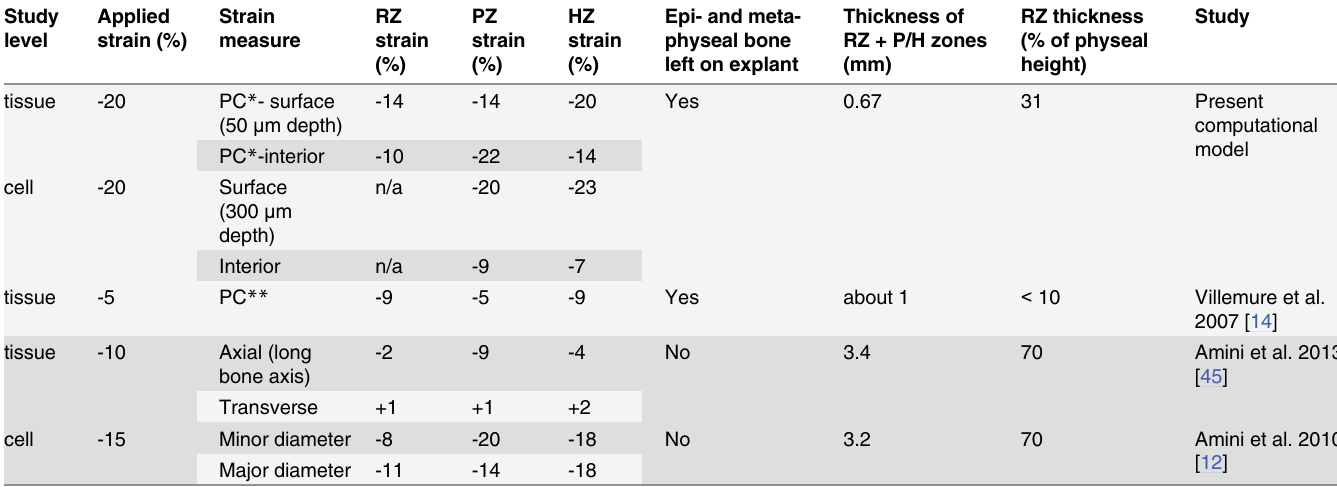
bone long axis. Cell strains were reported as minor and major cell diameter changes. Minor diameter: cells in the PZ have minor diameters in line with the axial